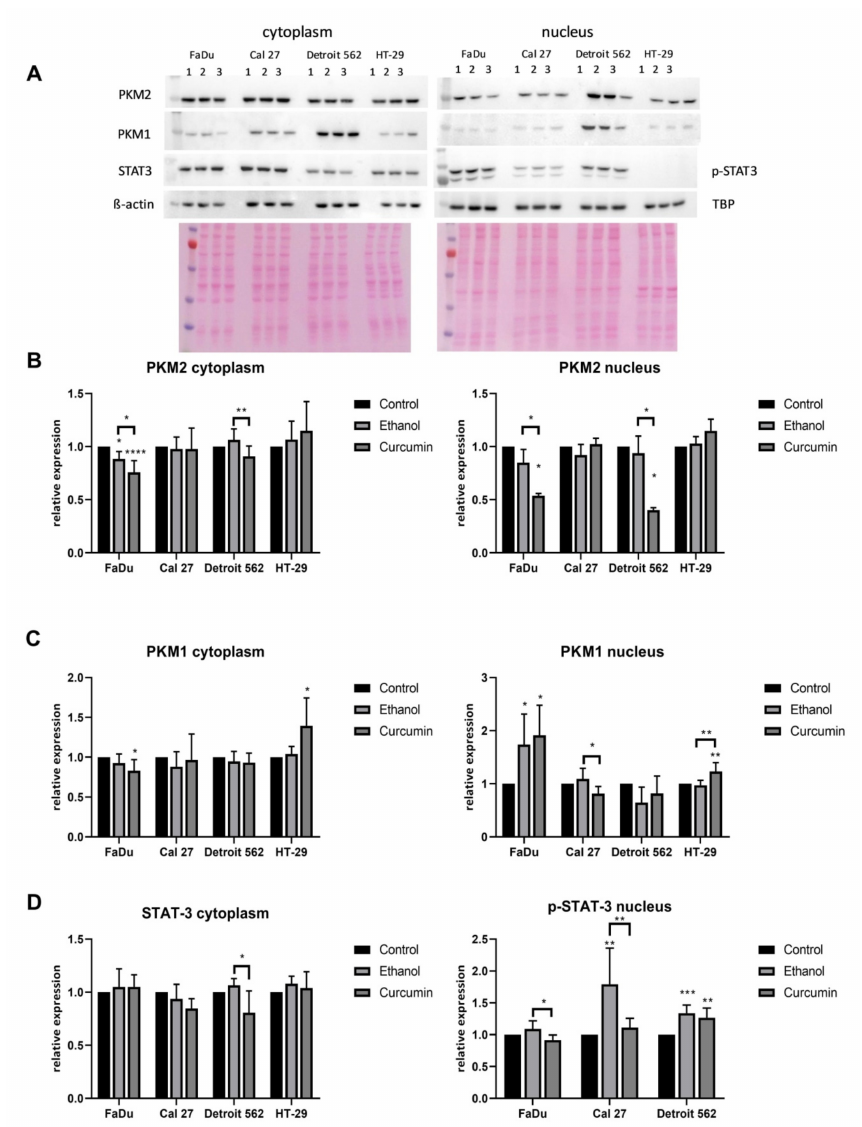
Figure 8. Expression of PKM1, PKM2 and STAT3 in cancer cell lines. Representative Western blots of cytoplasmic and nuclear PKM1, PKM2 and STAT3 content under different: ( A ) Western Blot. Lines: #1: control; #2: ethanol; #3: curcumin. Relative expression is calculated as compared to the untreated cells. ( B ) cytoplasmic and nuclear PKM2; ( C ) cytoplasmic and nuclear PKM1; ( D ) cytoplasmic non-phosphorylated and nuclear phosphorylated STAT3 (Y705). One-way ANOVA with Tukey post hoc test was used to test the differences in relative expression of selected proteins based on minimally five independent experiments. Values are shown as mean ± SD. n = 5–7. * p < 0.05; ** p < 0.01; *** p < 0.001; **** p <